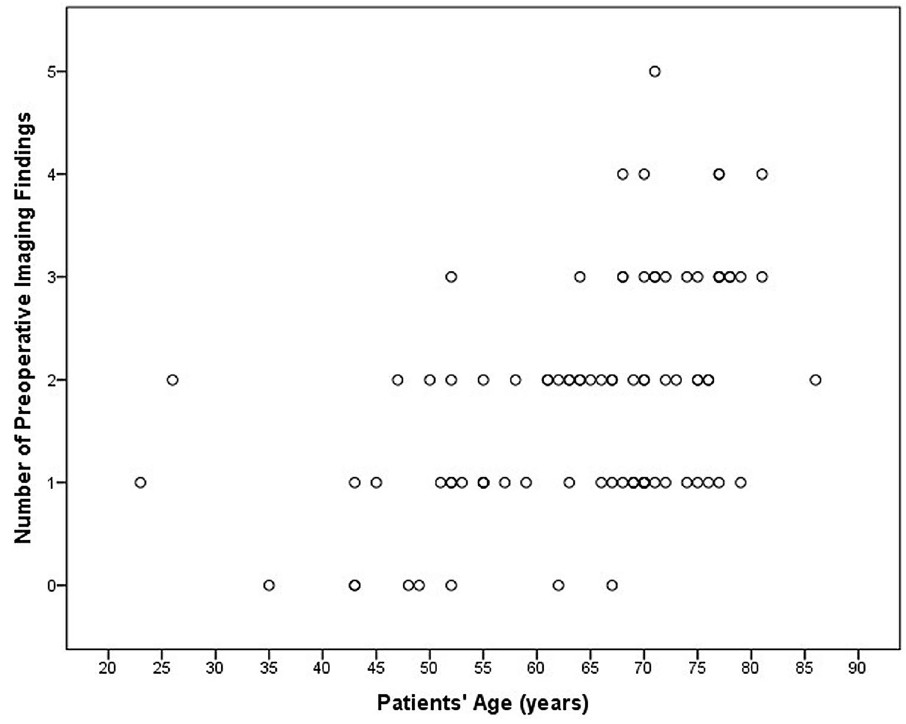
Figure 2. Correlation between number of preoperative neuroradiological findings in each patients and patient’s